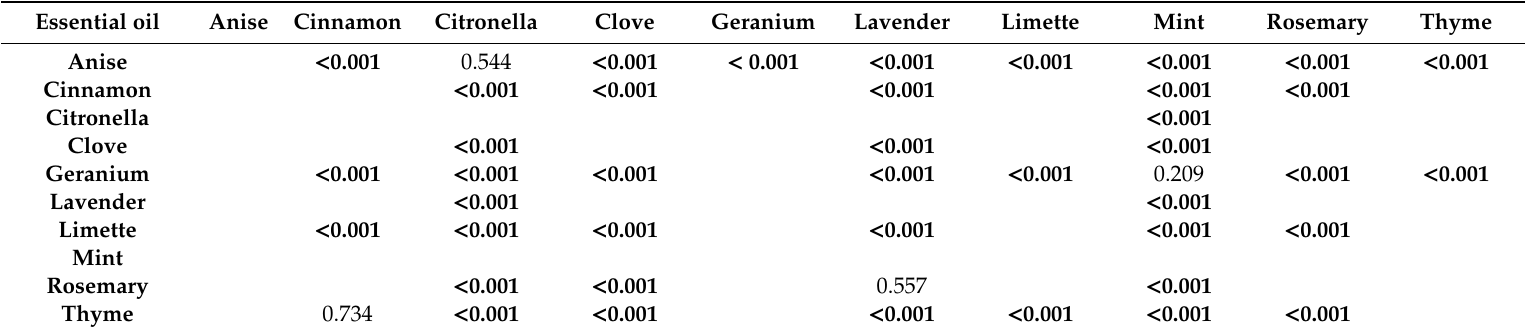
Table A2. Levels of statistical significance ( p ) in Fisher’s post-hoc test of EOs activity against L.